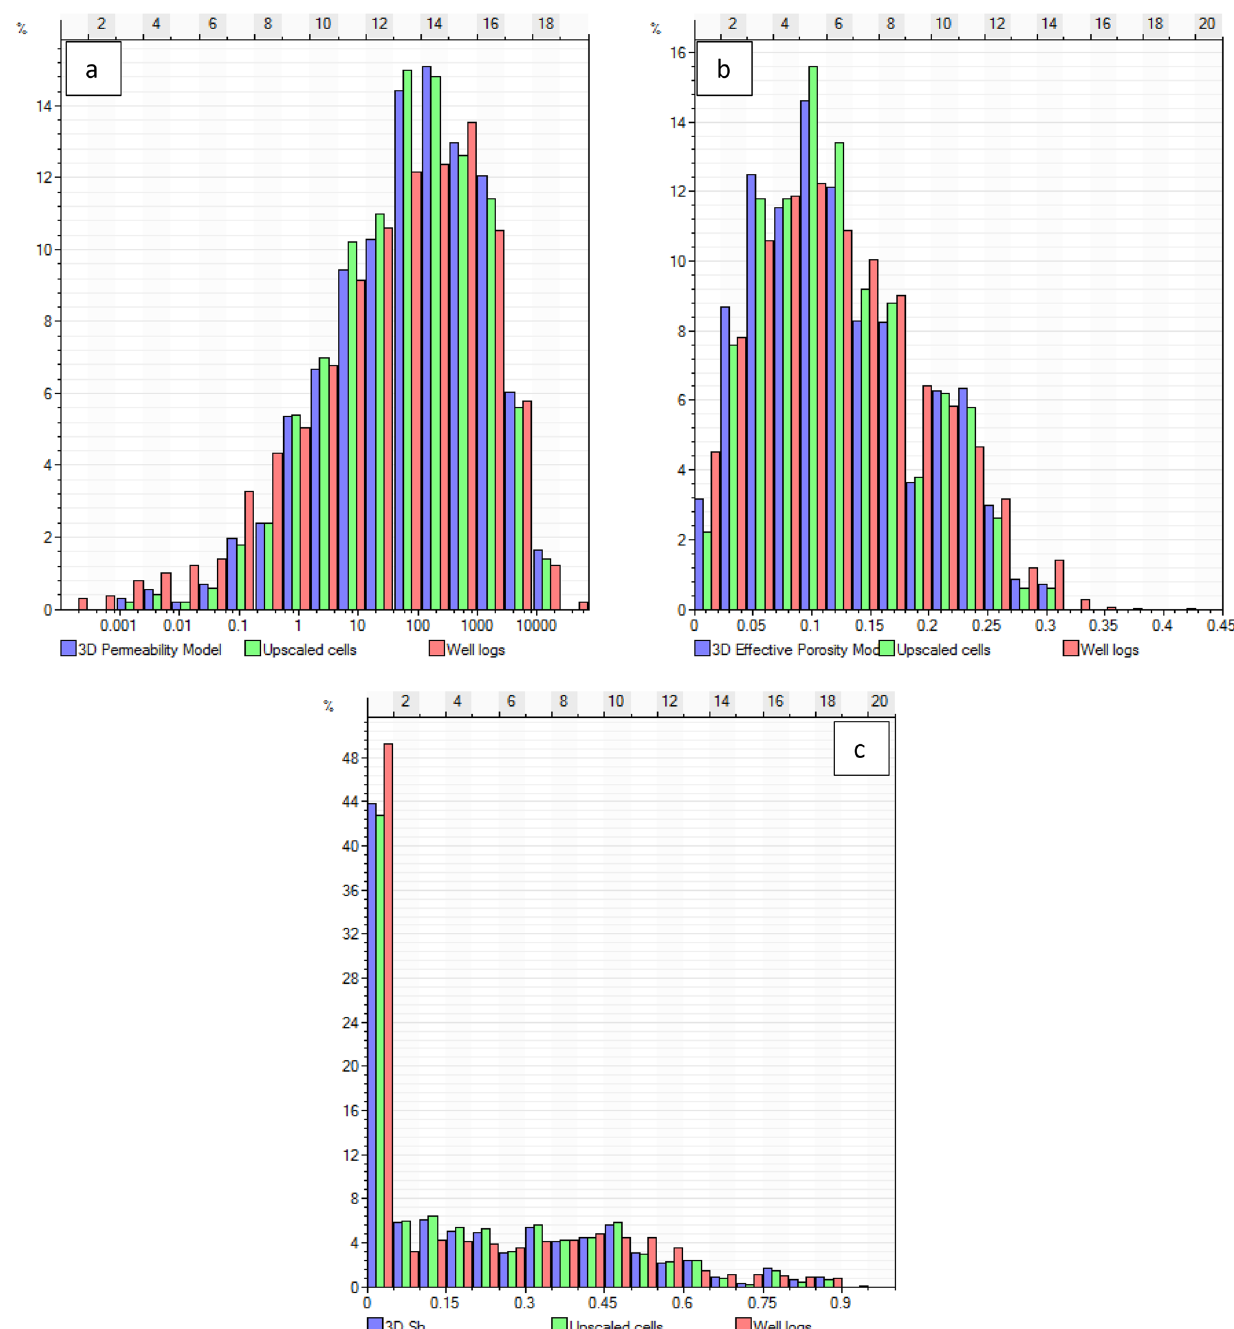
Fig. 7 Comparison of the estimated petrophysical properties distribution; a permeability, b effective porosity, c hydrocarbon